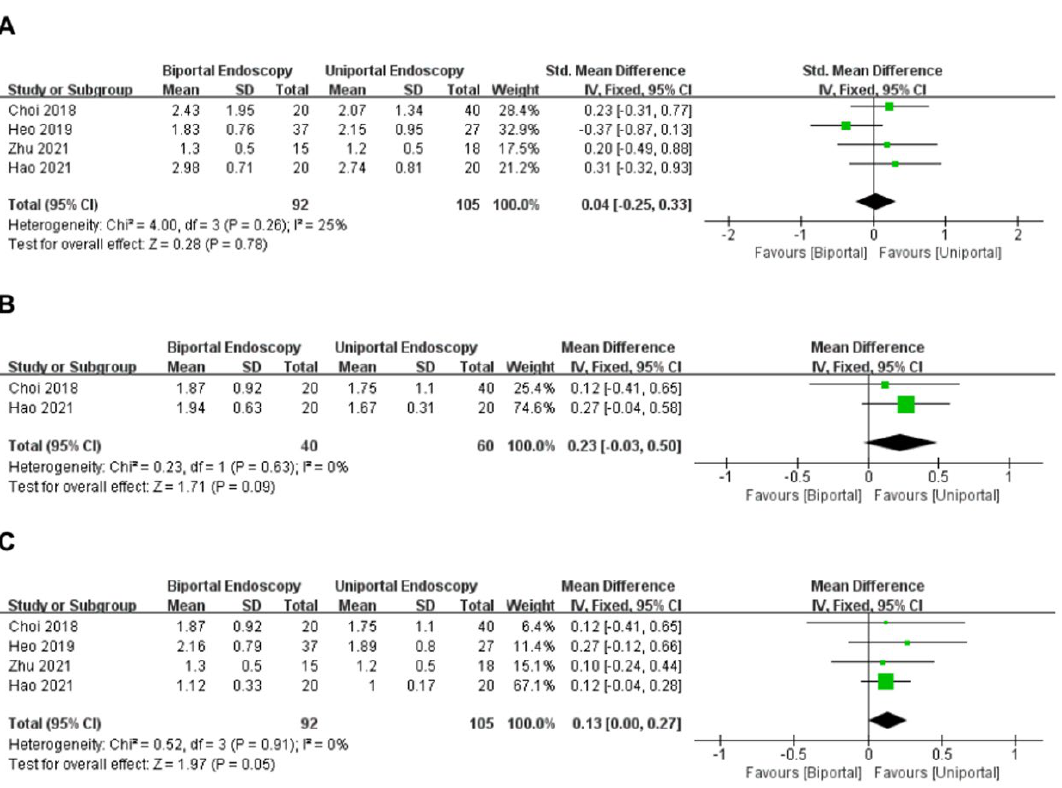
Figure 4. Forest plot of VAS leg pain score ( A ) within 3 days; ( B ) within 3 months; ( C ) last